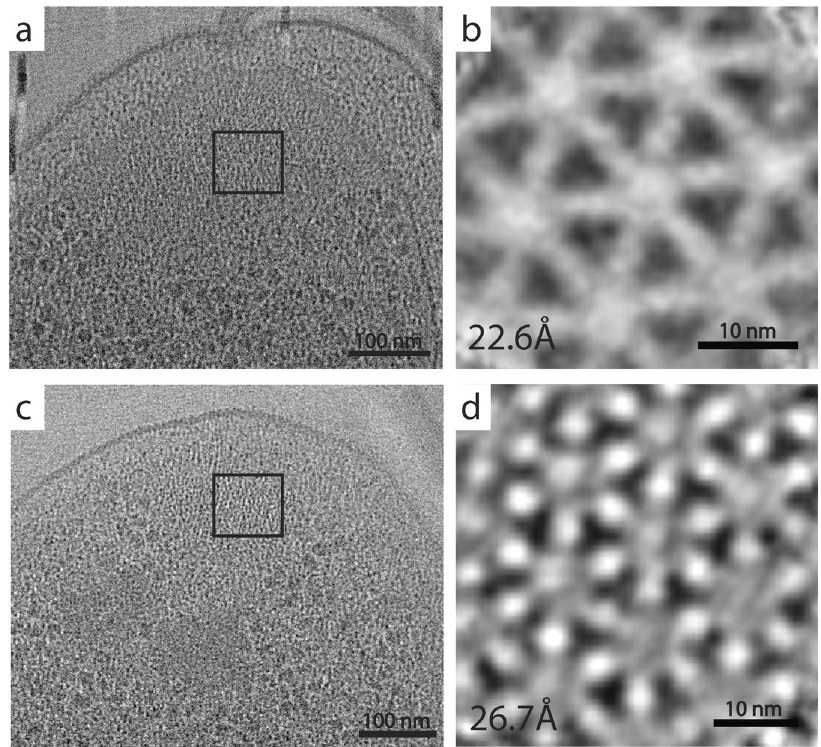
Fig. 1 Effect of UVC irradiation on Vibrio cholerae and its chemotaxis array . Representative tomographic slices showing the fl agellar pole region of untreated ( a ) and UVC-treated ( c ) V. cholerae cells, highlighting the top view of the F6 chemotaxis array (black box). b , d Results of sub-tomogram averaging of F6 chemotaxis cluster, showing the typical hexagonal arrangement of the trimer-of-dimer receptors in extended